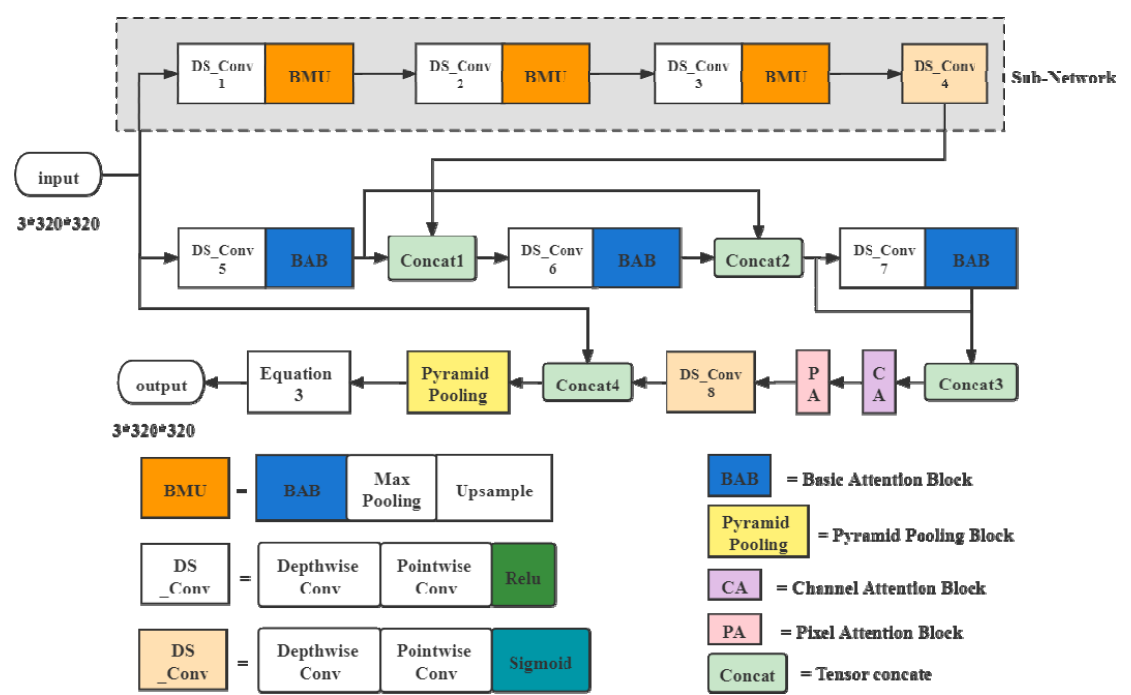
Figure 5. The end-to-end defogging network structure.